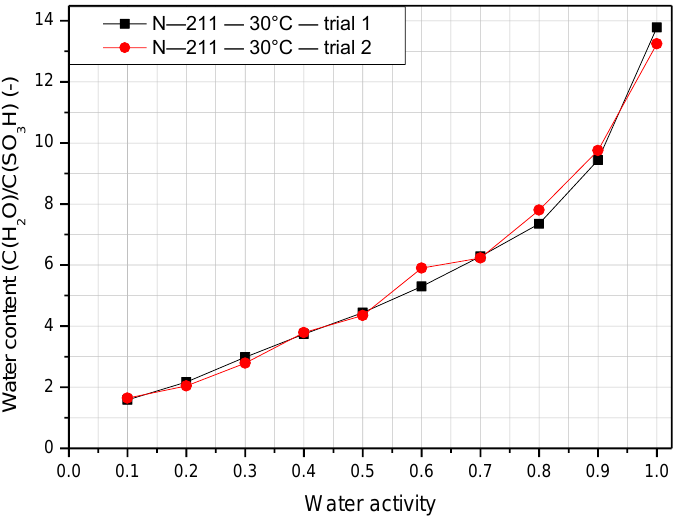
Figure 6. Water contents of Nafion 211 membrane at an operating temperature of 30 ◦ C. Because the water content is defined by the concentration of water vapor to the concentration of sulfonic acid (fixed charge) inside the membrane, the water content seems to vary at high temperatures. Figure 7 shows the water content of the N-117 membrane at 50 ◦ C and 70 ◦ C at varying relative humidity. When the temperature increases, the water content tends to rise as well. The maximum value of λ at 50 ◦ C is 15, and 70 ◦ C s 14.9 at 100% relative humidity. The water content increases sharply when the temperature increases from 30 ◦ C to 50 ◦ C. However, there is a slight difference in water content between the temperatures of 50 ◦ C and 70 ◦ C. At higher temperatures, the water content of N-117 is detected easily when the water activity is